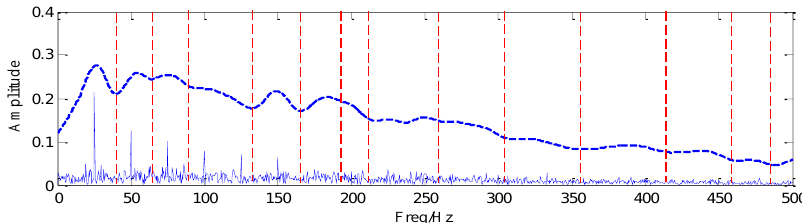
Figure 9. Result of frequency partition.